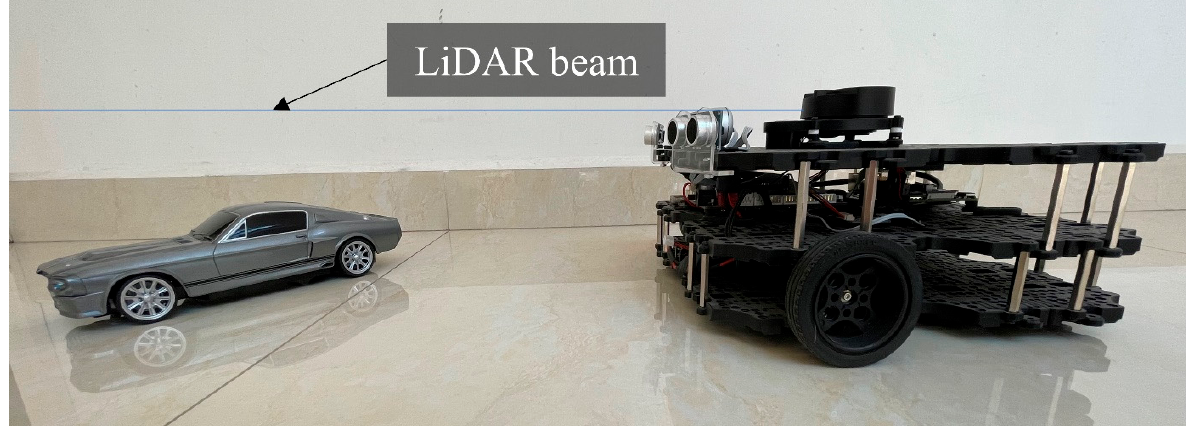
Figure 9. Sole 2D LiDAR beam does not detect shorter obstacles underneath it.